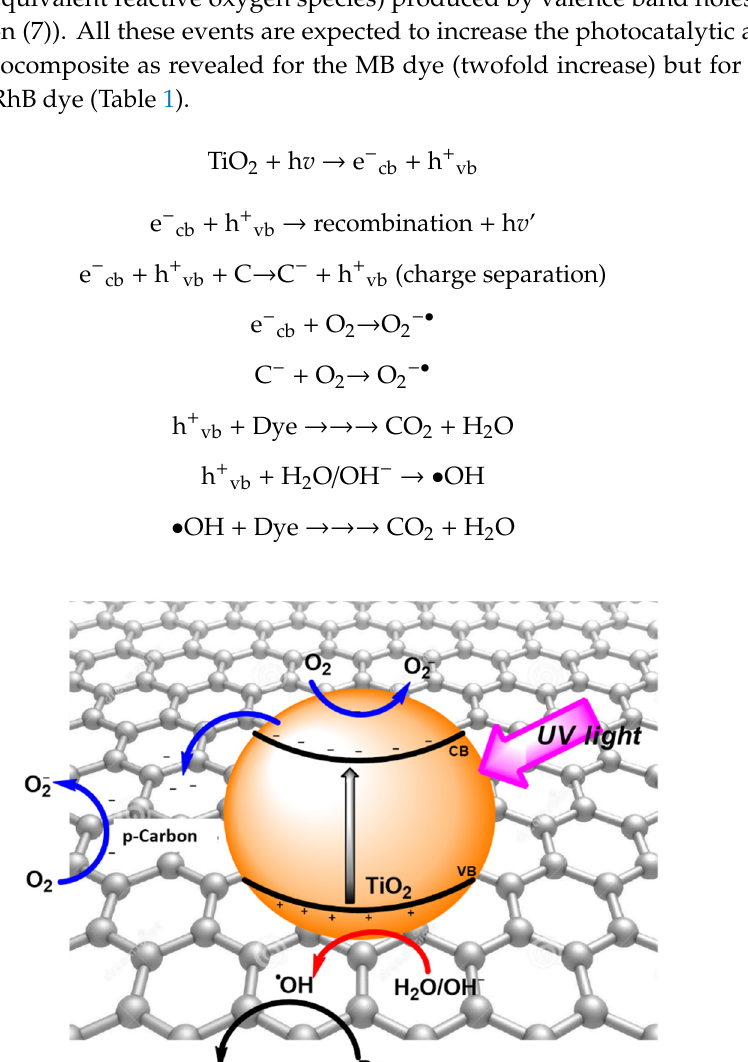
Figure 9. Schematic representation of the activity of the p-C/TiO 2 photocatalyst on dyes.